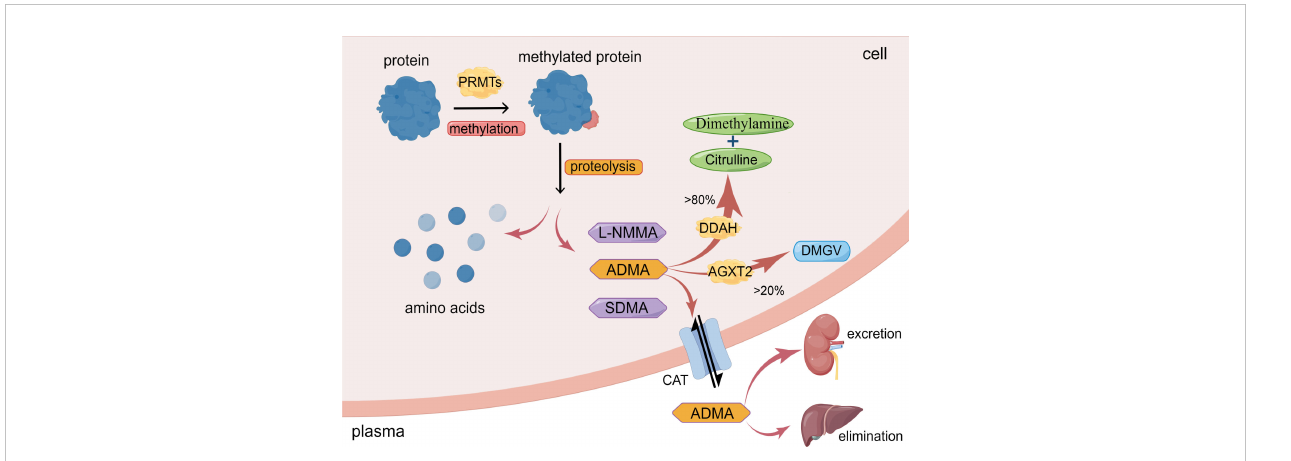
FIGURE 1 Synthesis and metabolism of ADMA. ADMA is formed by the post-transcriptional methylation of proteins mediated by PRMTs. Amino acids and methylarginines such as ADMA, L-NMMA, and SDMA are subsequently released during protein proteolysis. >80% ADMA is hydrolyzed by DDAH to dimethylamine and citrulline; <20% ADMA is degraded by AGXT2 to DMGV. ADMA can also enter circulation via CAT and excretion by the kidney or elimination by the liver. (The fi gure was created using